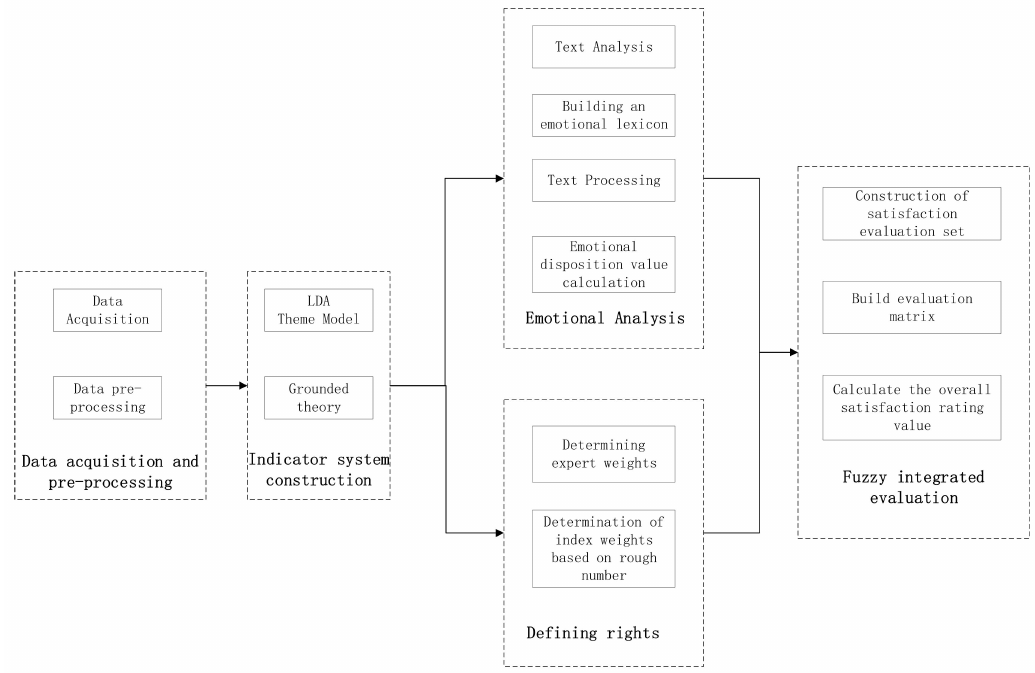
Figure 1. General framework